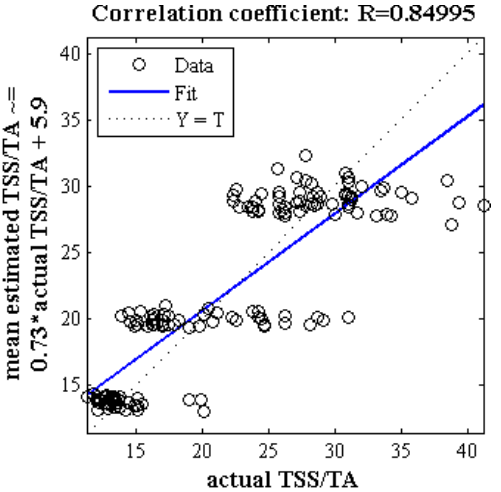
Figure 8. Correlation analysis of scatter plot between mean estimated and measured taste index of Gala apple by PLSR method based on spectral data related to key wavelengths in 300 iterations.